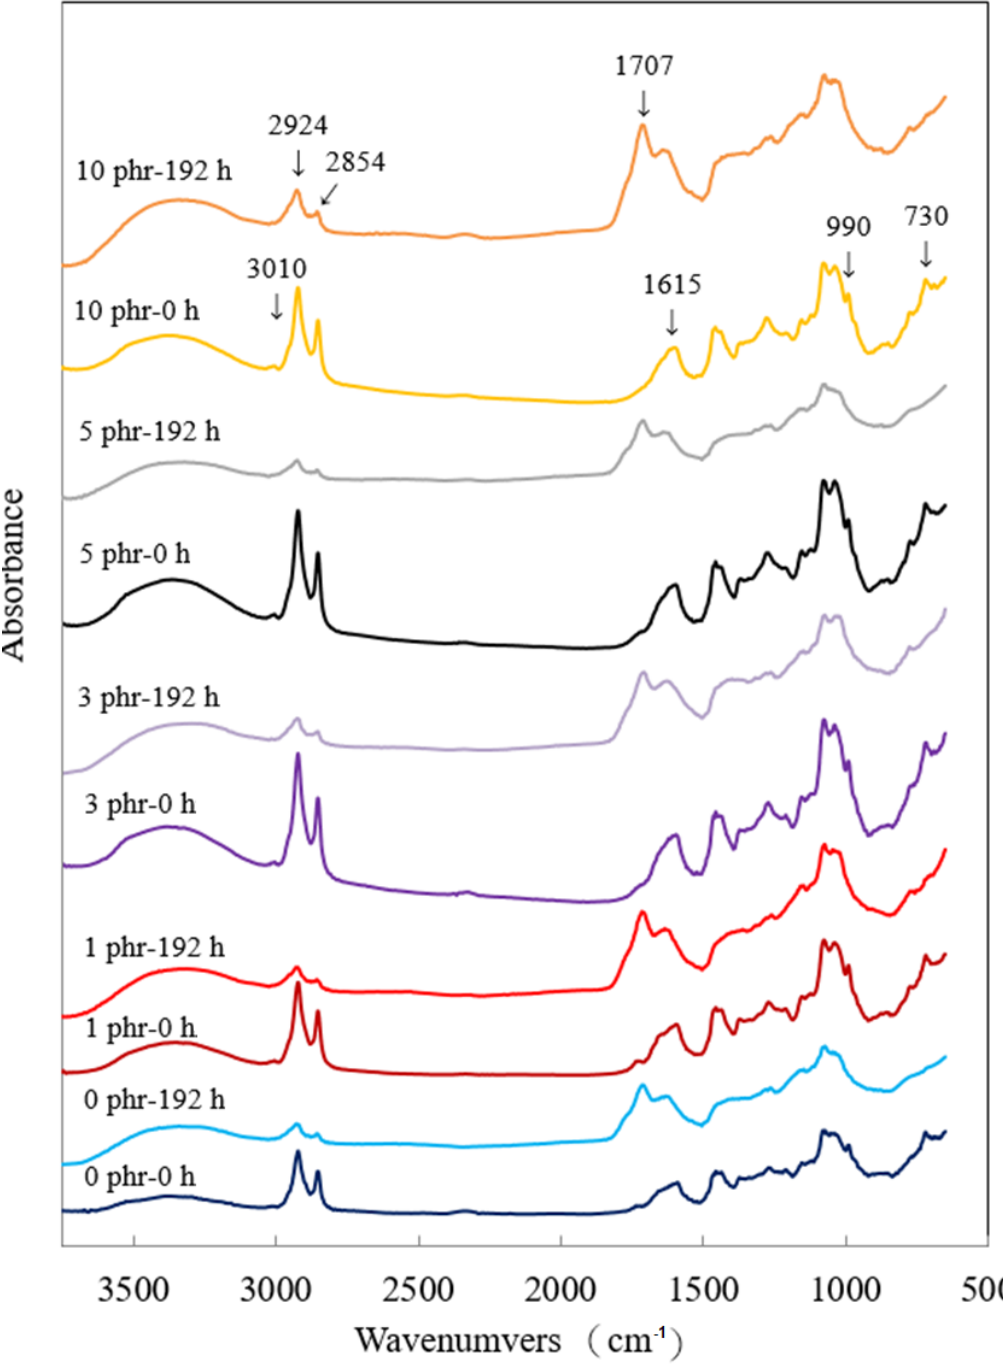
Figure 6. FTIR spectra of ROL films with various A. confusa heartwood extractive additions before and after UV irradiation test.